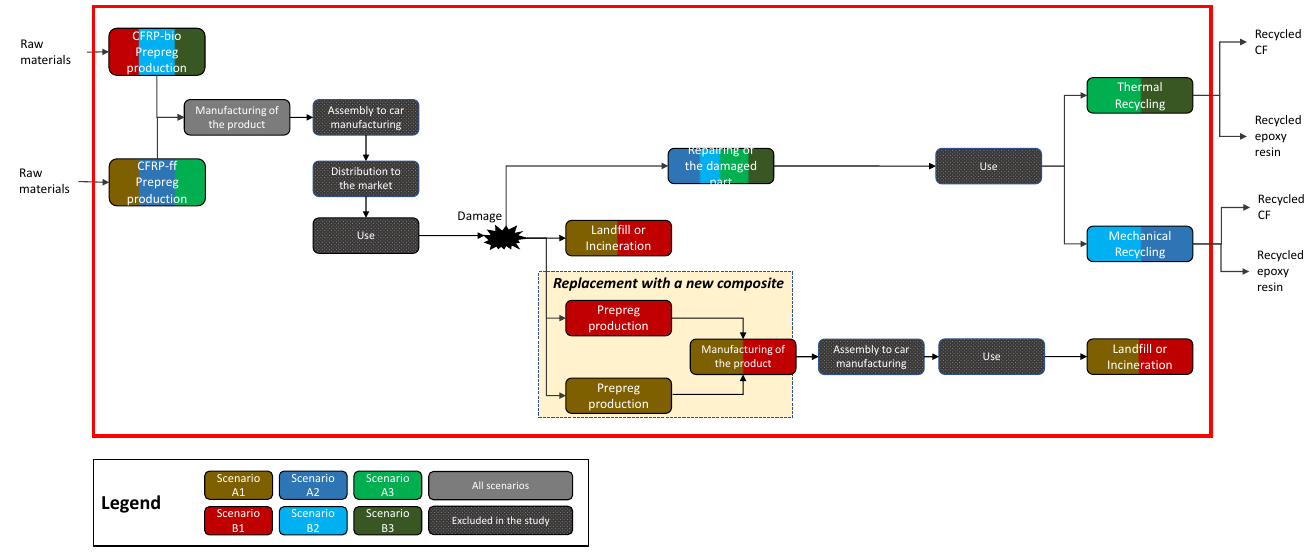
Figure 1. System boundaries of each scenario of the comparative